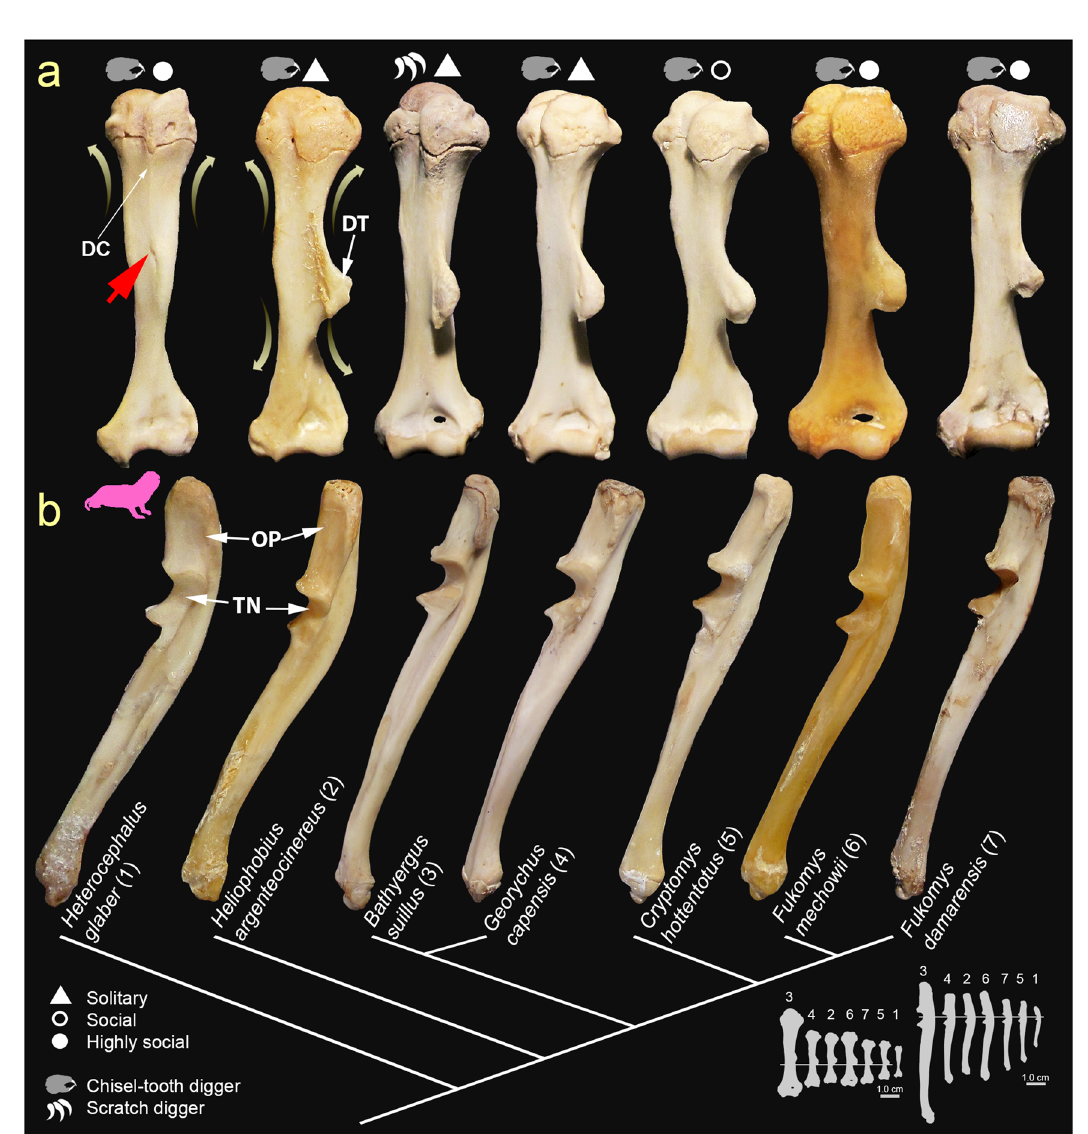
Fig. 1 Forelimb phenotype (humerus and ulna) and phylogeny of African mole-rats including main digging mode and social system. a Anterior view of humeri showing the projected deltoid tuberosity (DT) in all genera, except in Heterocephalus glaber (pink silhouette) that has a poor development of this feature, and a small scar for the insertion of the mm. deltoidei (red arrow head). Some specimens also showed a poorly developed deltopectoral crest (DC). Yellow arrows indicate the areas of bone thickening observed during ontogeny in all species, except for the distal portion of H. glaber , which remains narrow at the distal end. b Lateral view of ulnae showing the enlarged olecranon process (OP) and cortical thickening of the diaphysis under the trochlear notch (TN) in all species. Bone silhouettes show the real size of each bone among species, and correspond to the largest specimens of each species analyzed here. Phylogenetic relationships adapted from Upham et al. 79